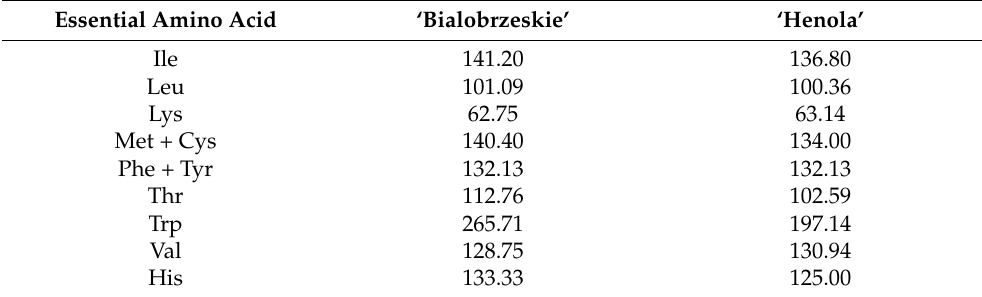
Table 5. Amino Acid Score (AAS) (%) for hemp protein according to protein pattern (IOM). Essential Amino